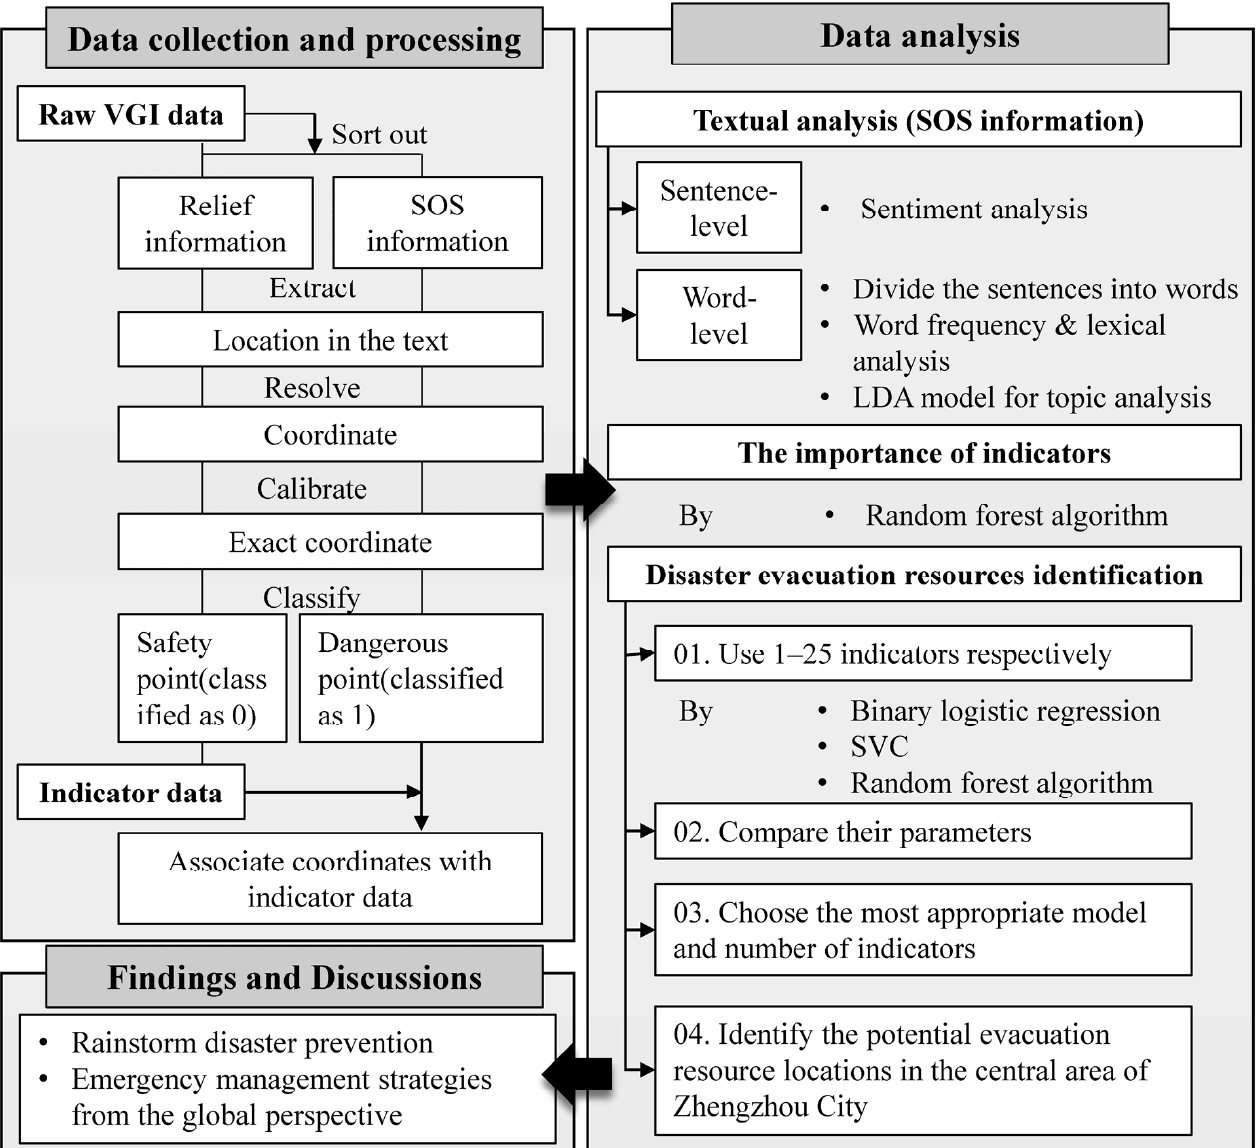
Figure 3. Workflow of the research.